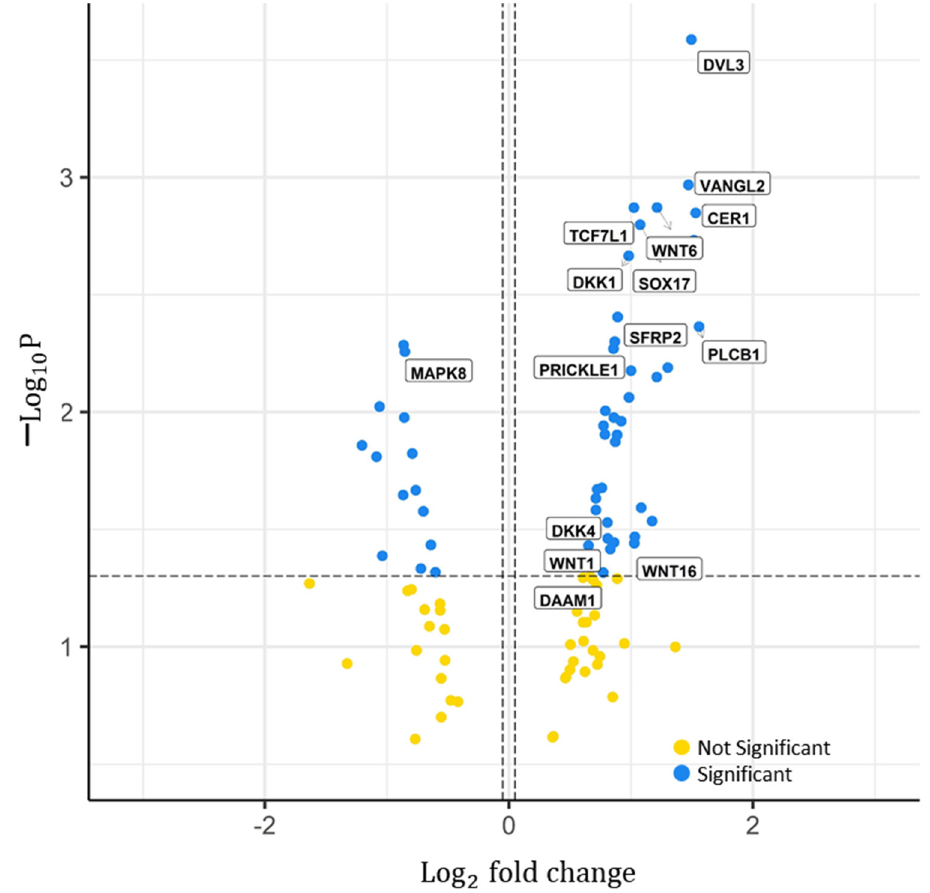
Figure 2. Significant genes in the WNT signalling pathway. Distribution of the p -value ( − log P) over the hazard ratio (Log fold change) from the genes analysed from the RNA Sequencing TCGA 2 legacy dataset. Features were divided in two; significant and not significant, represented by the blue and yellow dots, respectively. Labels represent the gene names of some significant features. p -value cut-off used = 0.05. Log fold change cut-off used = 0.5. Total number of features in WNT signalling 2 pathway = 119. Total number of significant genes determined =